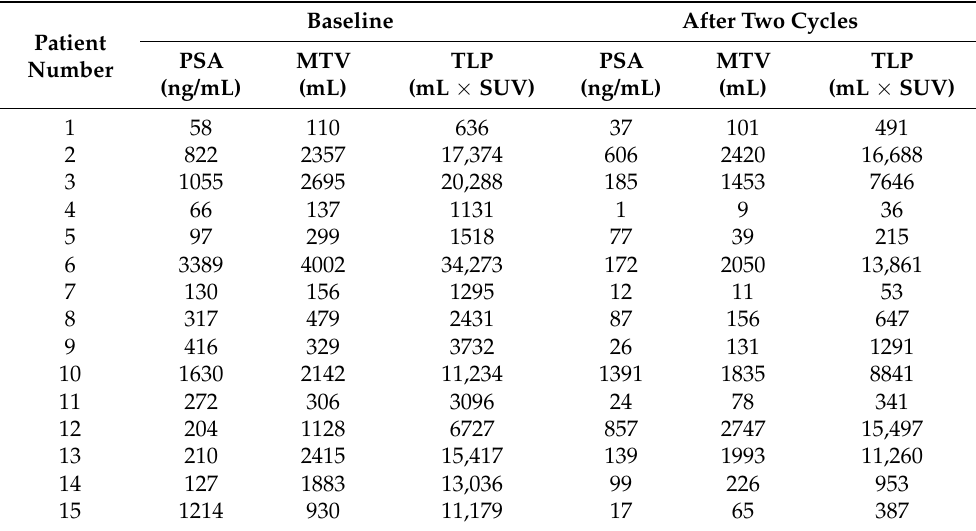
Table 2. Individual values of PSA, MTV and TLP at baseline and after two cycles of [ 177